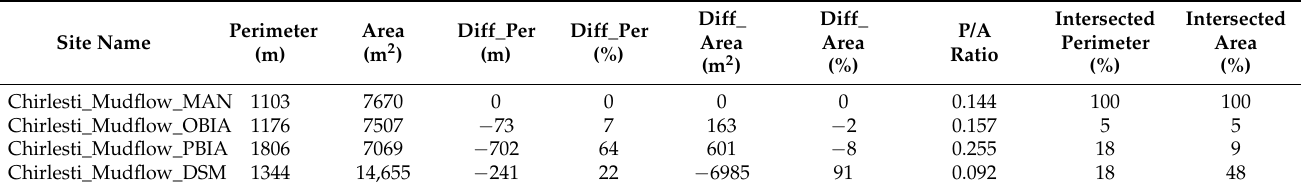
Figure 11. The results concerning the Chirlesti mudflow in Romania captured by the drone flight on 1 July 2021: ( a ) boundaries of affected area manually digitized; ( b ) segment mean shift (SMS) algorithm; ( c ) ISO Cluster unsupervised classification (initial based on the orthomosaic); and ( d ) ISO Cluster unsupervised classification (initial based on the SMS). Table 4. The statistics produced by each method for the Romanian